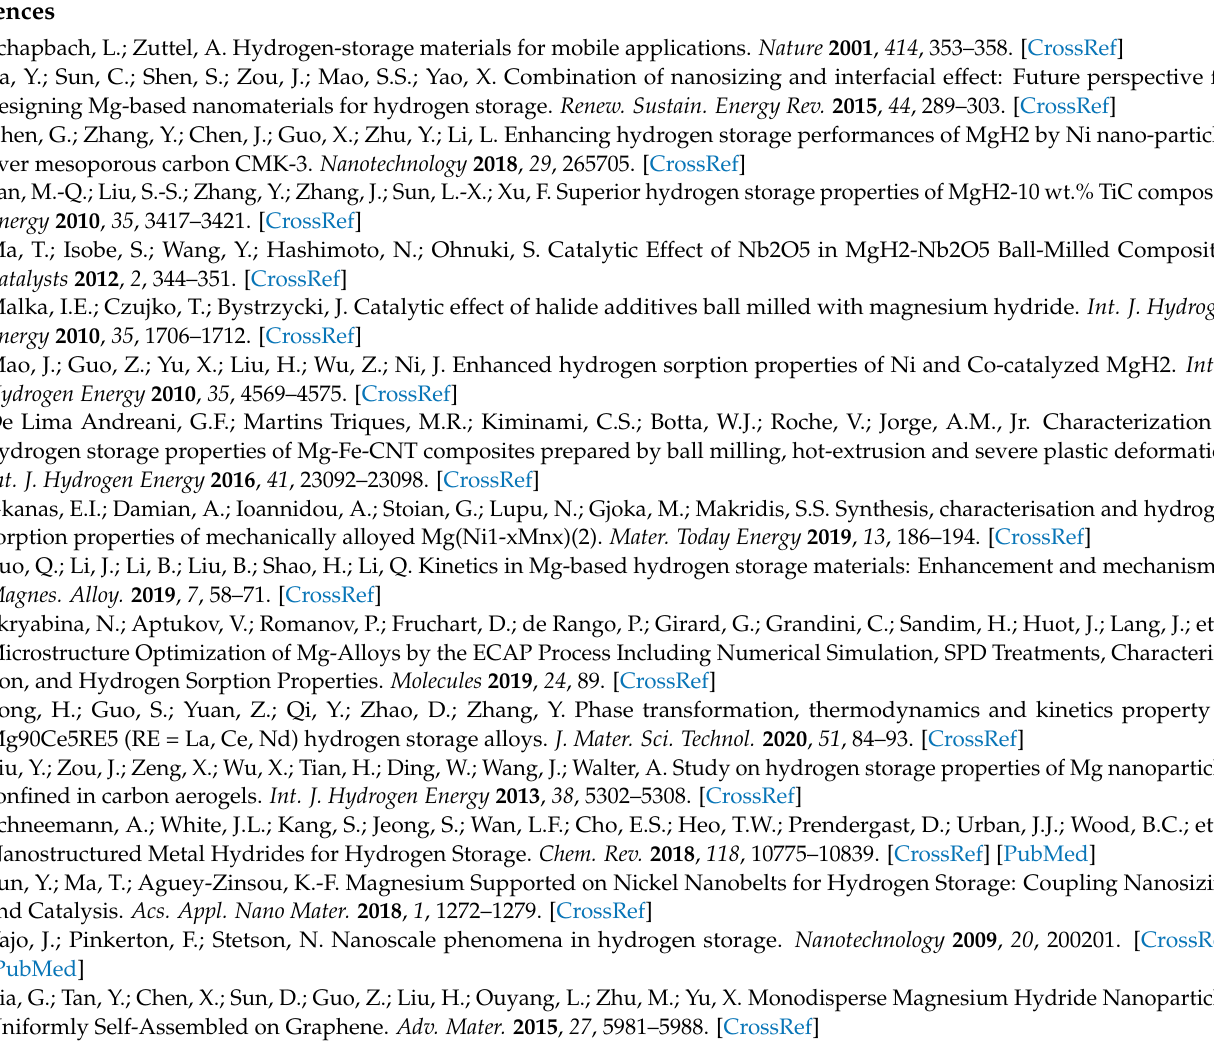
Figure S3: Electron image and corresponding elemental mappings of MgH 2 -6 wt.% ML-Ti 3 C 2 , Table S1: The quantitative information of the experimental details, Table S2: Initial dehydrogenation temperature and hydrogen desorption capacity of different additive amount of ML-Ti 3 C 2 , Table S3: The initial hydrogenation temperature and hydrogen absorption capacity of MgH 2 -6 wt.% ML-Ti 3 C 2 and as-milled MgH 2